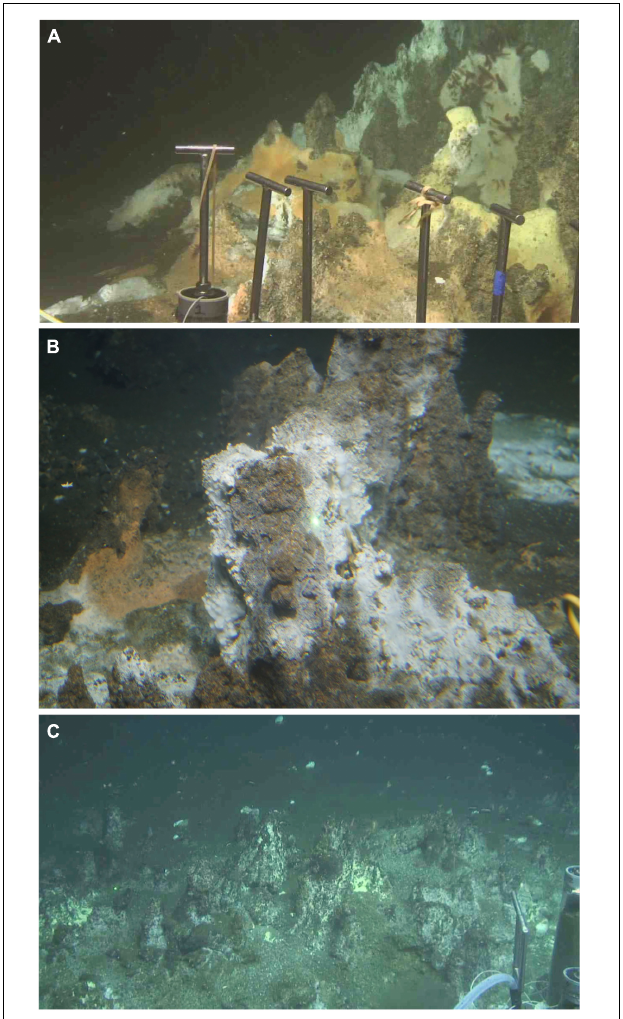
FIGURE 1 | Hydrocarbon-rich hydrothermal sites in Guaymas Basin. (A) Hydrocarbon-soaked concretions at the base of the “Rebecca’s